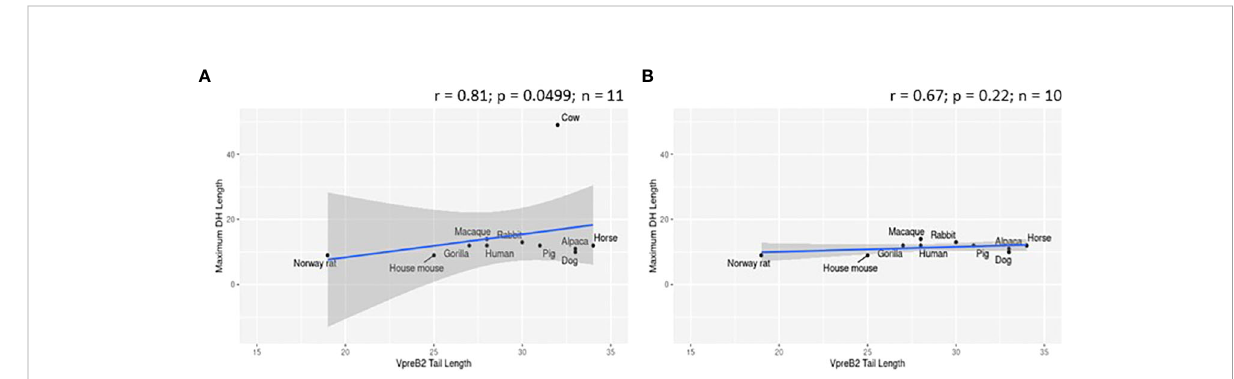
FIGURE 6 VpreB2 tails are longer in species with elongated DH gene segments. (A) VpreB2 tail lengths are highly correlated with maximum DH length (r= 0.81; p=0.0499; n = 6). (B) However, this relationship disappears when cattle are removed from the dataset (r=-0.029; p=0.957; n =